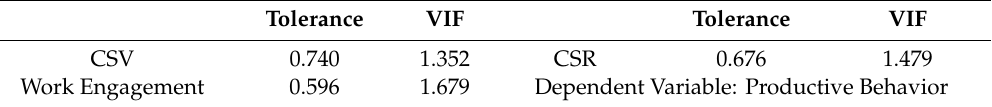
Table 6. Variance inflation factor (VIF) and tolerance.